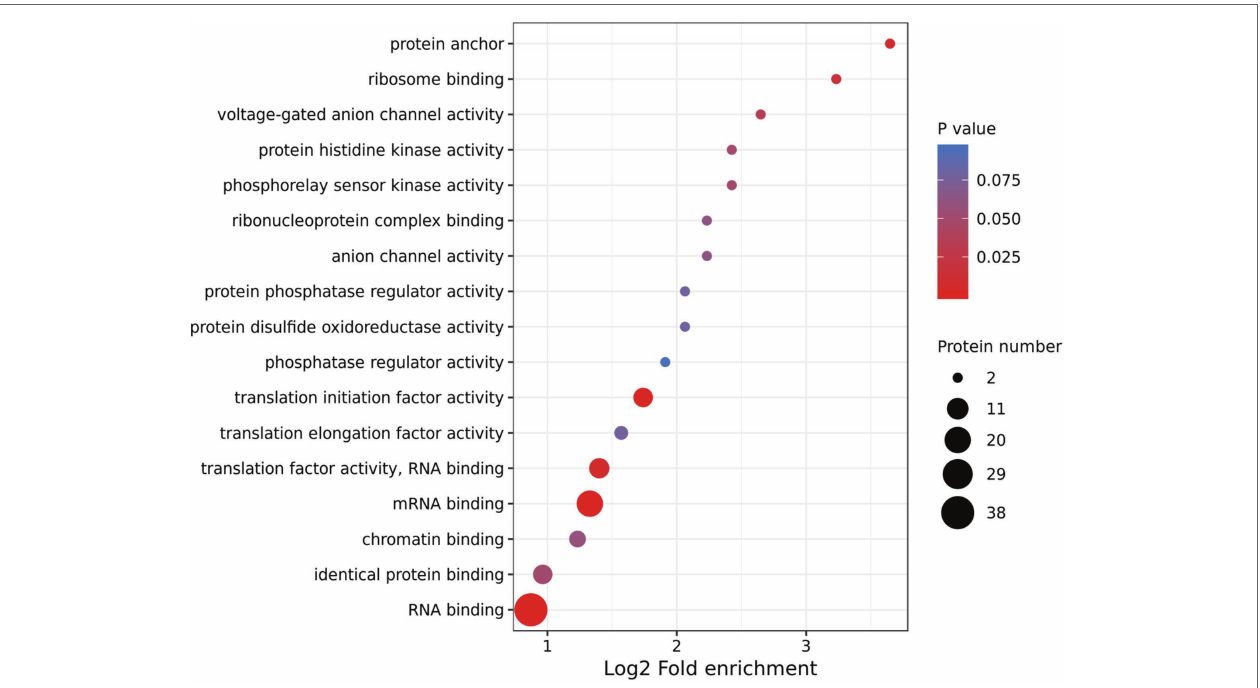
FIGURE 4 | Gene Ontology (GO) analysis of differentially phosphorylated proteins by warm temperature. GO annotation was derived from the UniProt-GOA database or with the InterProScan software. The GO category Molecular Function is